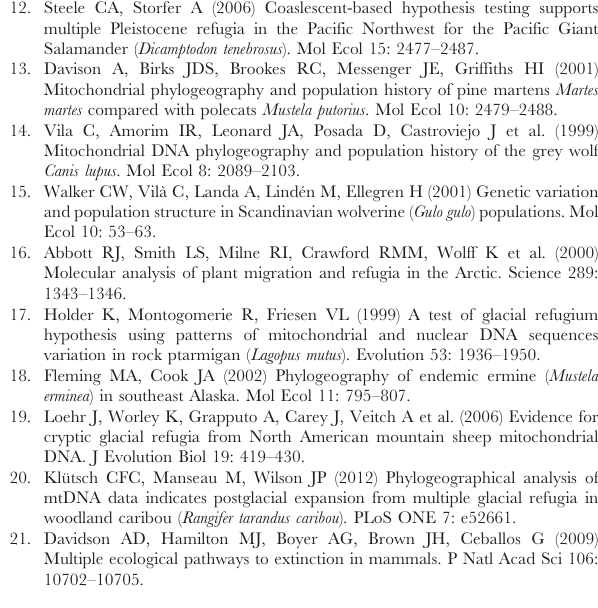
Figure S1 Mismatch distribution. Pairwise mismatch dis- tribution performed on mtDNA haplotypes among individuals. Bars represent observed values, a solid line represents the expected distribution according to the sudden expansion model, and dotted lines show 6 95% confidence intervals. Table S1 Catalogue information of all wolverine sam- ples obtained from collections and if samples were sequenced.